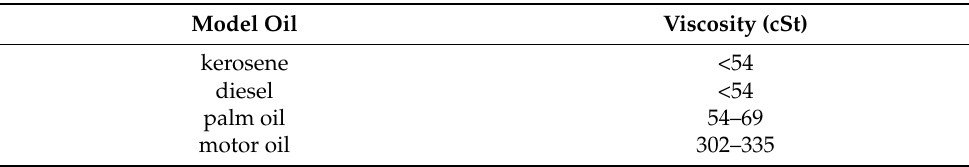
Table 1. Viscosity of model oils at room temperature. Model